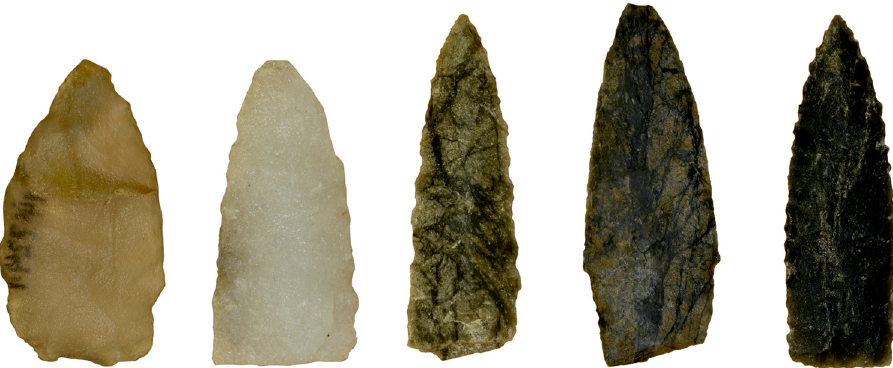
Figure 3: Quartzite points from Västerbotten County, Sweden. The petrographic heterogeneity varies signi fi cantly between the points, which needs to be considered when sampling for non - destructive analysis. Depending on what parts of the surface are sampled for spectroscopic analysis the results may di ff er signi fi cantly. Artefacts derive from the collections at Västerbottens museum ( www.vbm.se ) . Photograph by the author.